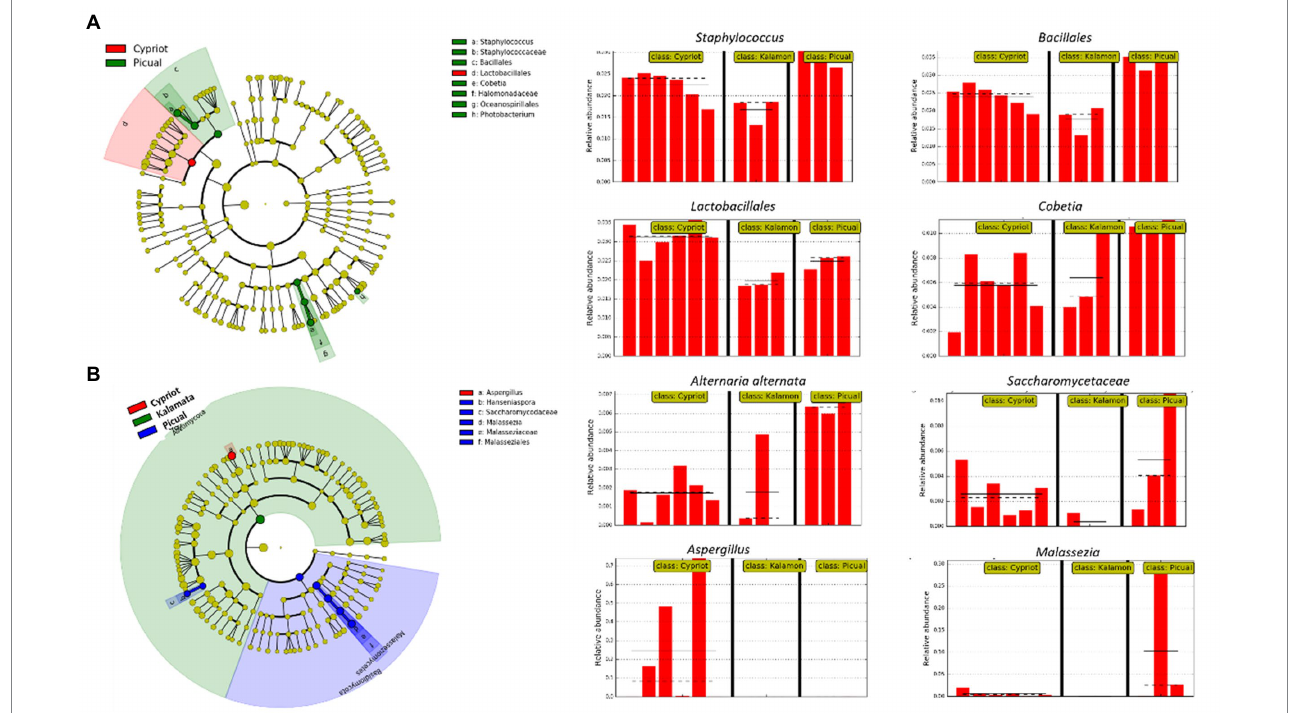
FIGURE 4 Biomarkers discovery using the LEfSe algorithm showing bacterial (A) and fungal (B) taxa that indicated significant over-representation among the different olive varieties (Cypriot, Kalamata and Picual), based on a non-parametric factorial Kruskal–Wallis (KW) sum–rank test, an (unpaired) Wilcoxon rank–sum test, and LDA. The left part of the picture depicts phylogenetic trees that map the taxonomic differences of the detected biomarkers from class (outside part of the circle) to species level (inside part of the circle), combined with a list of taxa with significantly increased representation in Cypriot olives (red color) and Picual variety (green colour regarding bacteria, blue colour regarding fungi). The right part of the picture shows histograms of the taxa that indicated significantly increased relative representation in the studied varieties, their relative abundances, and in how many samples they were detected.